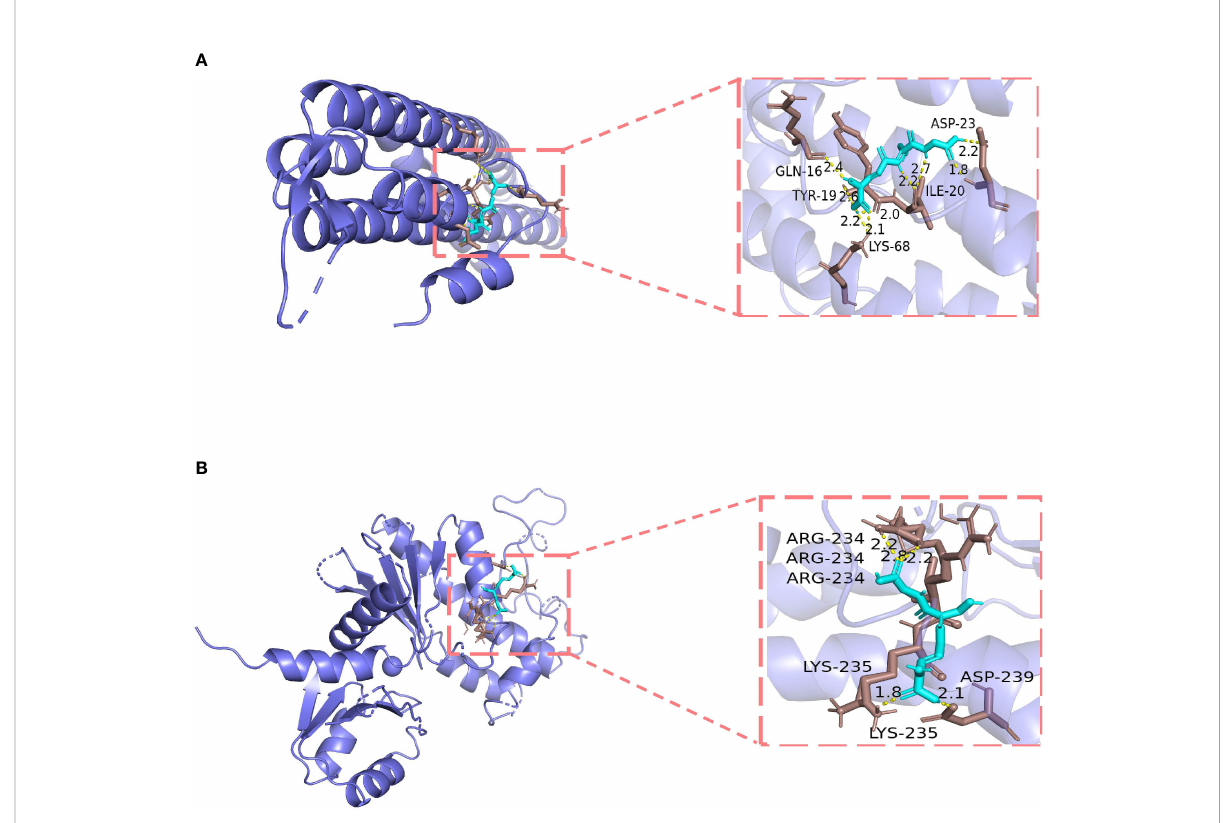
FIGURE 7 Molecular docking models of glutathione (GSH) binding to its targets. (A) GSH binds to CAV1. (B) GSH binds to TLR4.